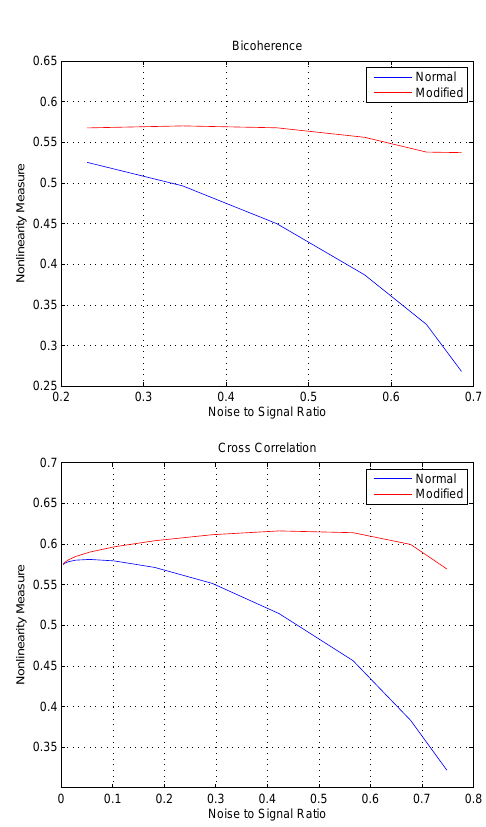
Figure 8: Modification of nonlinearity measures with Top. index NLI 23. Bottom. index NLI